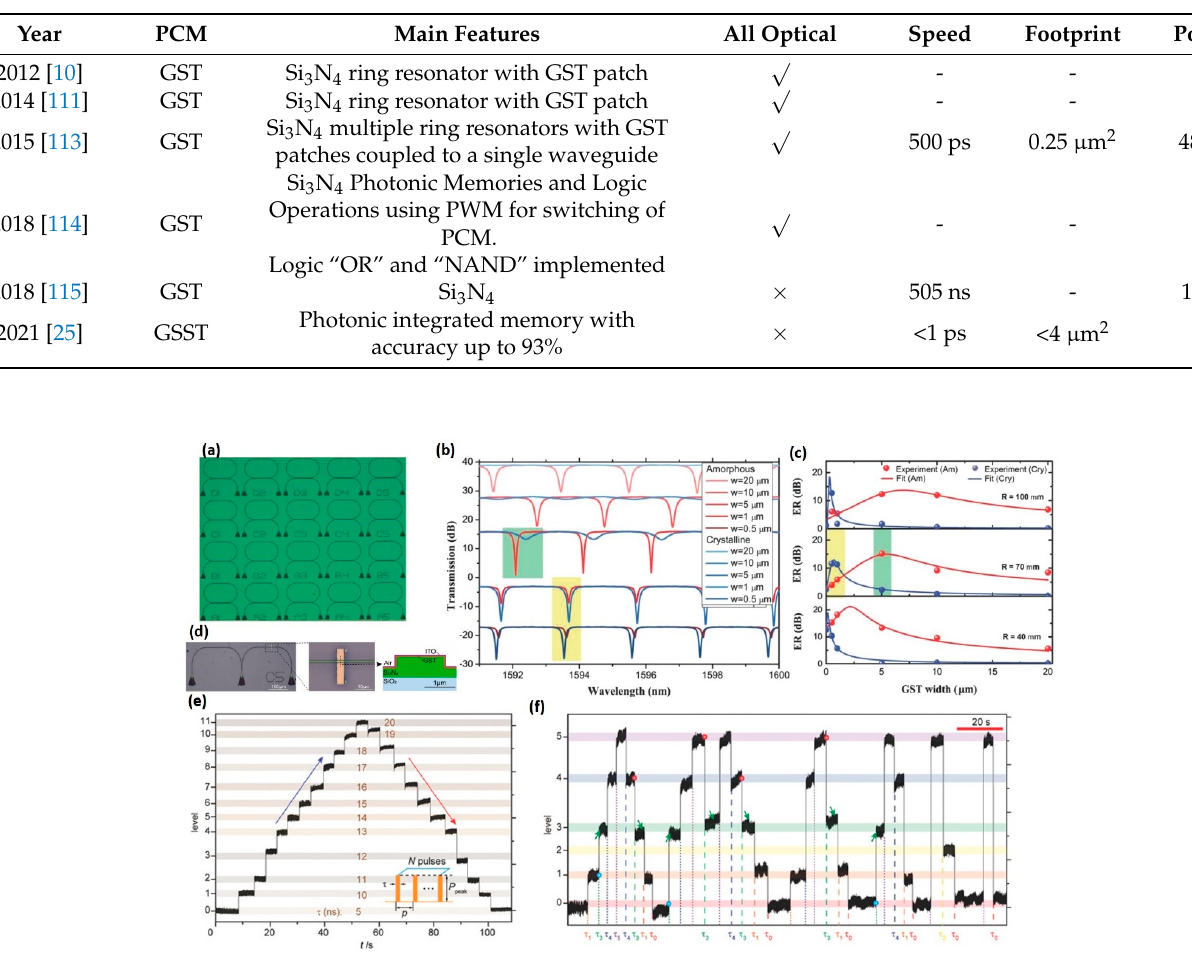
Figure 7. Implementation of phase change memories. ( a ) Microscopic image different memory elements. Along the horizontal axis, the waveguide–resonator gap is varied from 0.5 to 1.5 µm with 0.3 µm successive step size. Along the vertical direction, the width of GST varies from 0.5 µm (bottom) to 20 µm (top). ( b ) Comparison between resonances in the crystalline and amorphous states for different GST widths. The graphs show a relative shift of the central wavelength and the reduction of the Q-factor with broadening of the peaks. ( c ) ER obtained for different racetrack radii (R) as a function of GST width and state. The highlighted regions correspond to those highlighted in ( b ), and the lines correspond to the fits obtained using the analytical function for ER. ( d ) Concept of the dual-pulse programming technique; from left to right, an optical image of the device with a GST photonic memory cell, a magnified image of GST on top of the waveguide, and a schematic cross-section of the completed device [116]. ( e ) Experimental demonstration of multilevel photonic memory using multi-pulse PWM with 12 different levels in a single device showing the relative change in transmission ( Δ Tr/Tr0). This is an implementation of a switch for the photonic memory with each level accessed through the multiple identical pulse trains of 10 pulses with p = 30 ns and P peak = 1.4 mW. ( f ) Randomly accessing six levels of a single photonic memory. A multiple identical pulse train is used to reach different levels, with N = 12, p = 20 ns, and P peak = 1.6 mW. Each level can be reached with the same pulse train at a determined width ( τ 0 to τ 5) from any previous level, where τ 0 = 10 ns, τ 1 = 10.5 ns, τ 2 = 11 ns, τ 3 = 11.5 ns, τ 4 = 12.5 ns, and τ 5 = 15 ns. The dotted and dashed lines denote the times when optical pulse trains are applied for amorphization and crystallization, respectively. (( a – c ) reproduced with permission [111]; ( d )